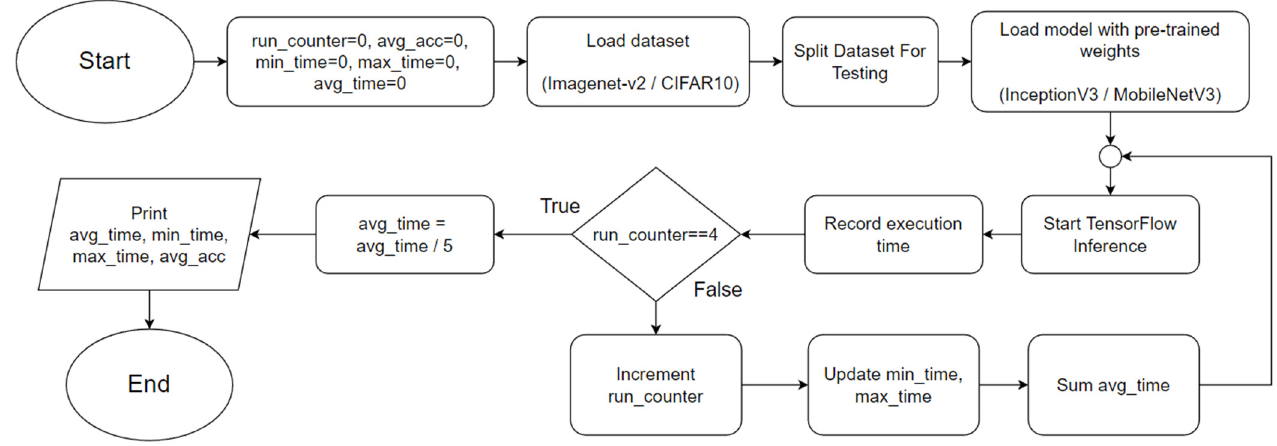
Figure 1. General flowchart for the Python programs used in Experiment 1.